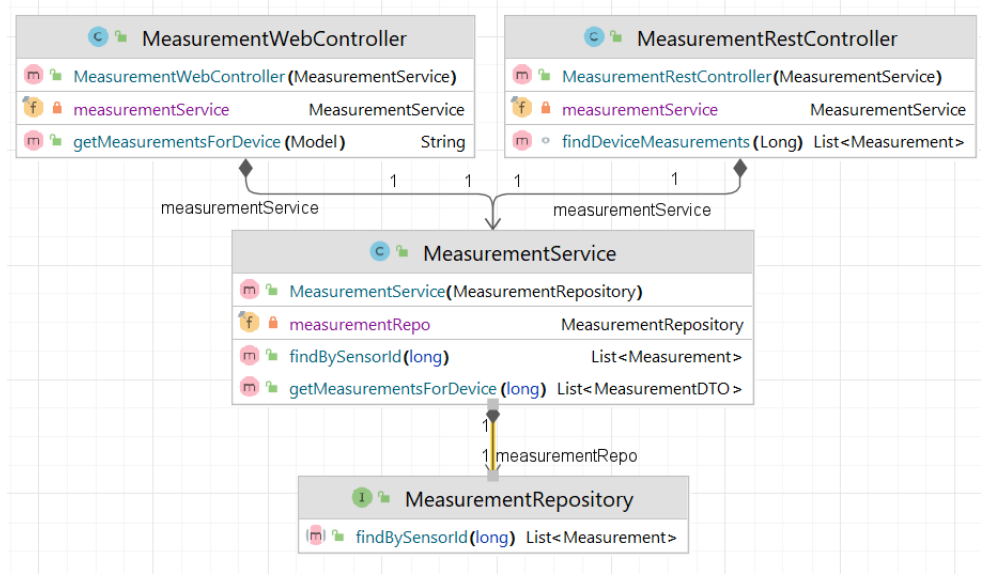
Figure 2. Class diagram for data